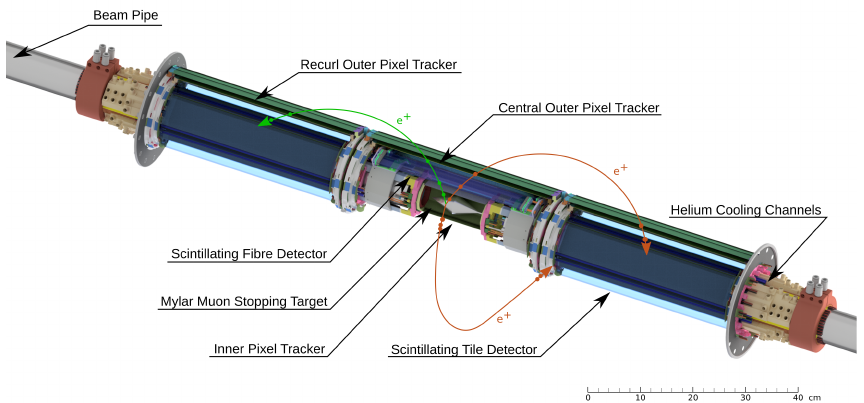
Figure 3. Active part of the Mu3e detector, with a central tracker surrounding the target, and the upstream and downstream tracking stations. The large lever arm created by the recurling tracks enables the high momentum resolution required.